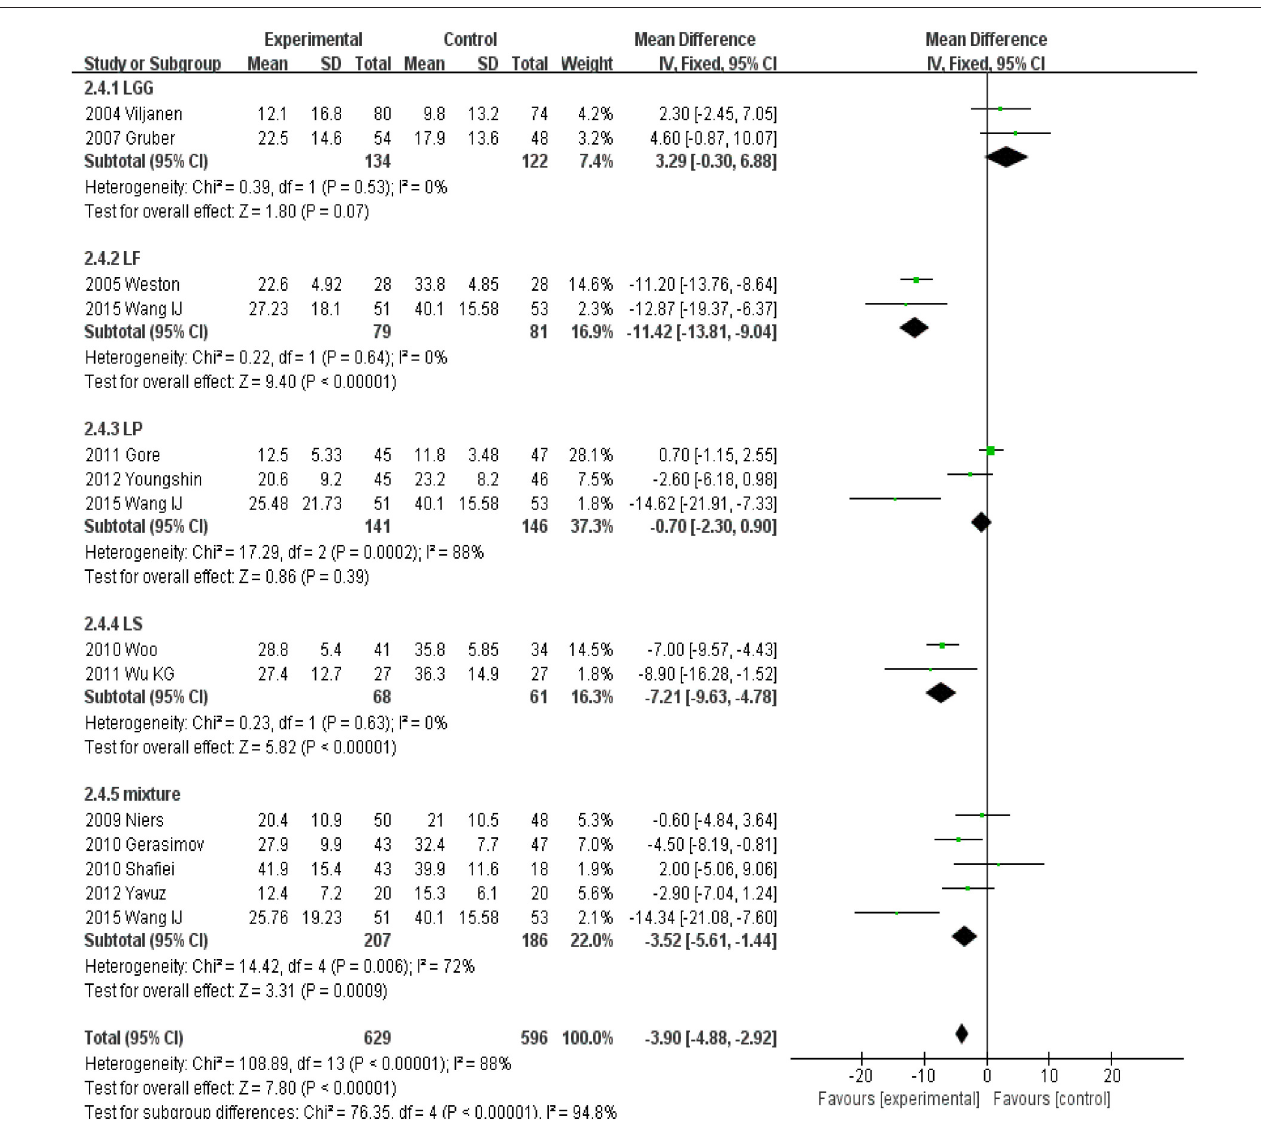
FIGURE 6 | MD scoring with probiotics treatment compared to control and placebo interventions by cultured